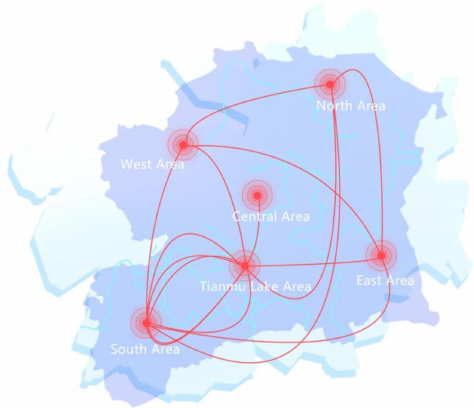
Figure 13. Regional tourism flow spatial distribution